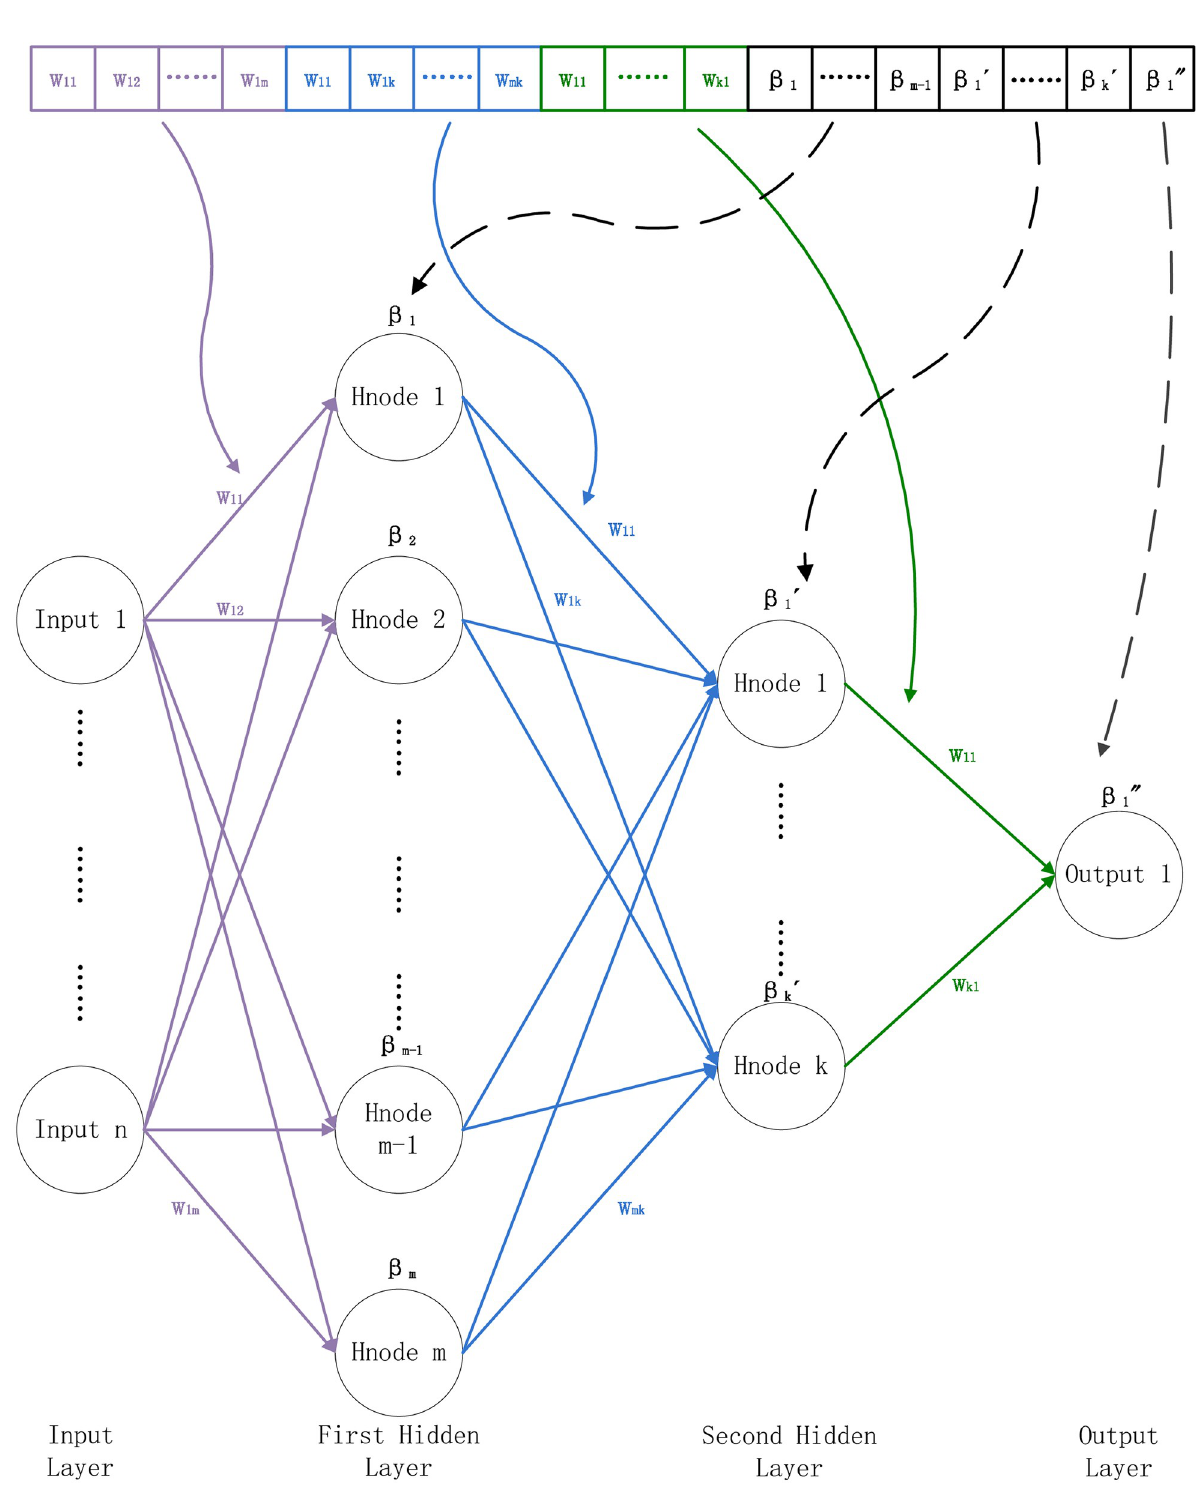
Fig 5. Weights and biases assignments of the Multi-Layer Perceptron (MLP) with two layers.